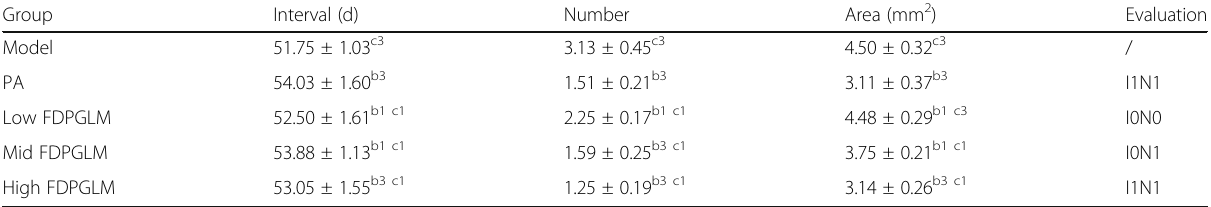
Table 1 Effect of FDPGLM on the total interval, number of ulcers, and area in a ROU rat model ( x (cid:1) s , n = 8)